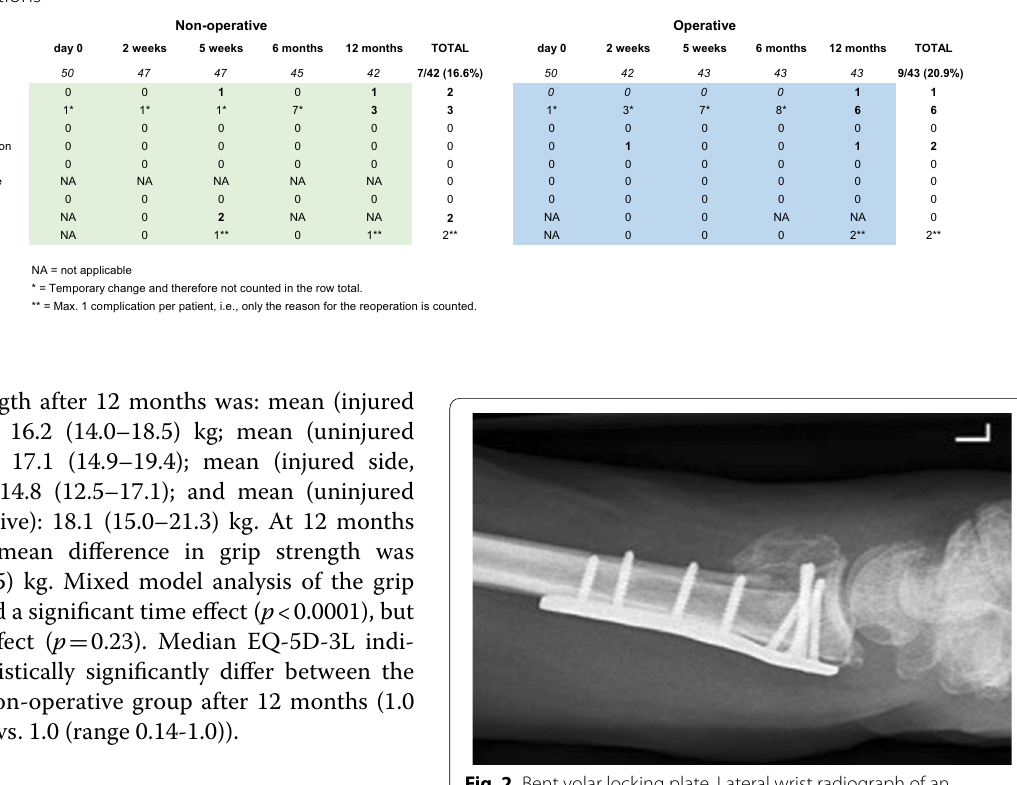
and non-operatively treated patients were reported in the existing literature [10, 20]. However, a meta-analysis that included not only RCTs but also prospective studies found a significantly lower Quick-DASH score favour- ing the operative group in the first year [19]. That meta- analysis found an effect size of 5.22 (95% CI 8.87 − − to 1.57). In the present study, the mean difference in − Quick-DASH was 4.2 (95% CI – 4 to 12), which was also well below the threshold for a minimal clinically relevant difference, 16–20 points. Likewise, the ROM was similar between groups, and the statistically significant differ- ence in flexion–extension ROM at 5 weeks and 6 months was barely clinically relevant, i.e., the mean difference after 12 months was 6.8° ( 3.2 to 16.7°, p 0.61). − = Not all patients are ideal for non-operative treat- ment. The NCG recommend operative treatment in older patients with unstable DRF unless they have a low functional demand [3]. The same holds true in Norway [22]. In contrast, based on the same literature that was